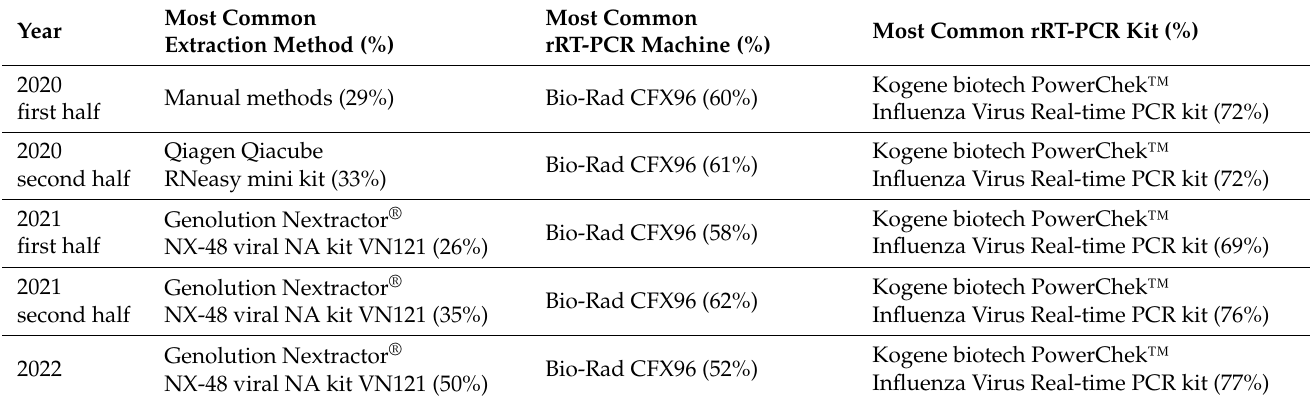
Table 3. Most used experimental instruments and kits in participating laboratories for PT.